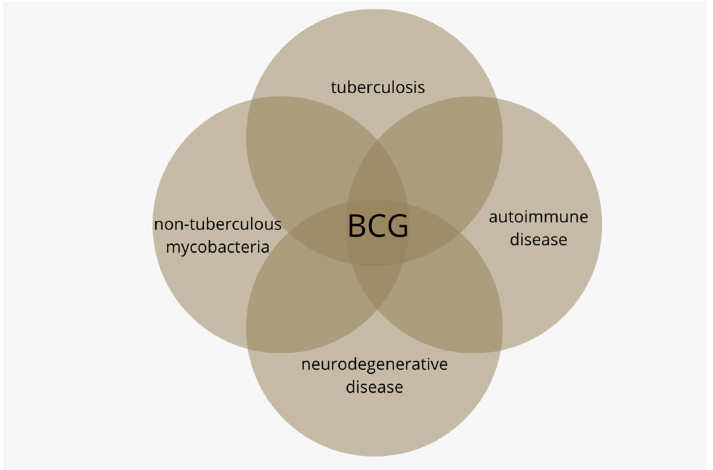
Figure 1. The Bacillus Calmette-Guérin (BCG) vaccine was originally developed to vaccinate against tuberculosis. BCG is also known to lessen the disease burden caused by non-tuberculous mycobac- teria (NTM). Currently, BCG is being studied in autoimmune diseases T1D and multiple sclerosis and in neurodegenerative diseases Alzheimer’s and Parkinson’s.